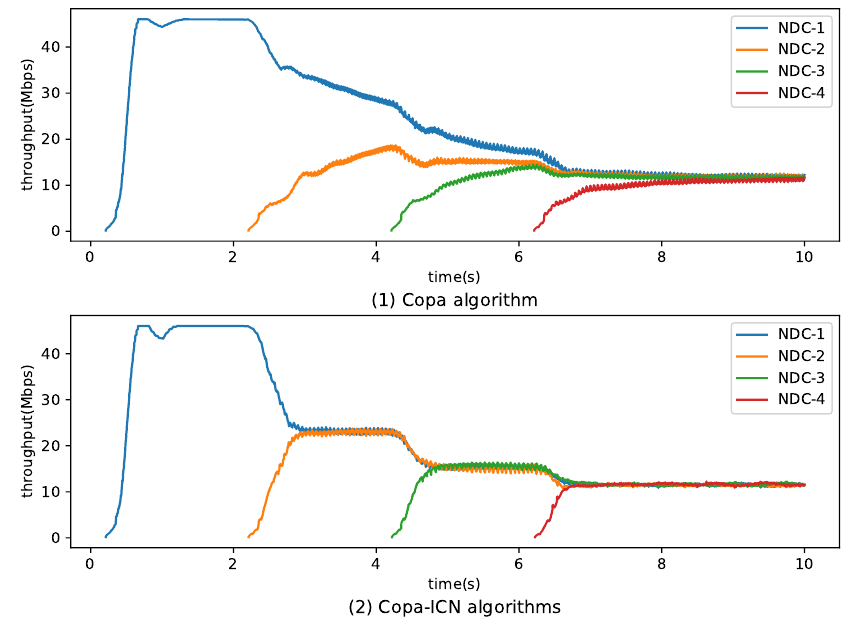
Figure 10. The throughput of the transmission process started at 4 different times over time.